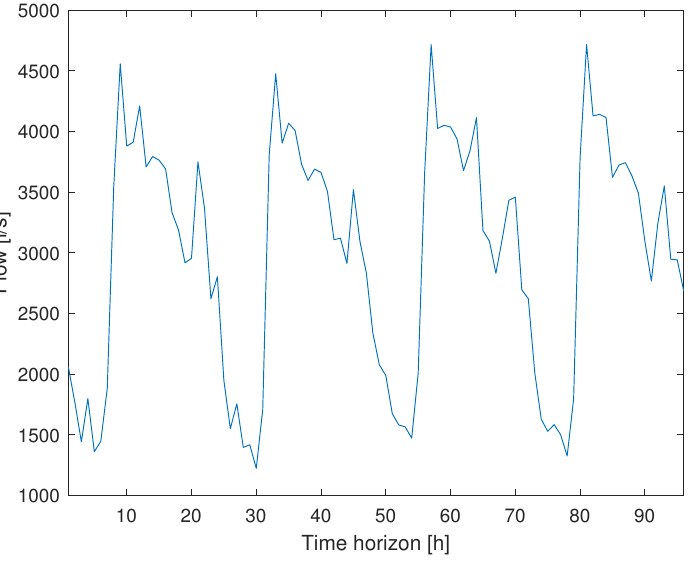
Figure 2. Flow consumption.